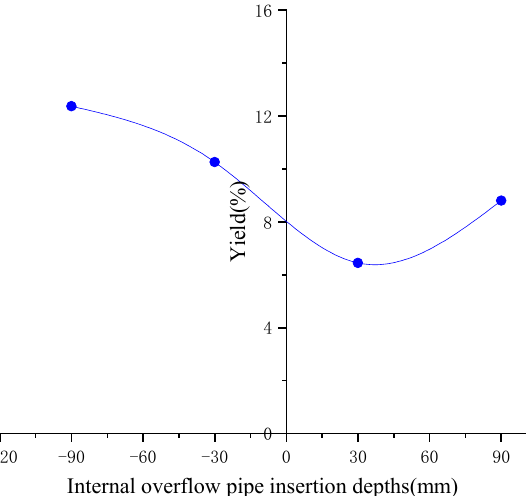
Figure 10. Internal overflow yield of different internal vortex finder insertion depths.